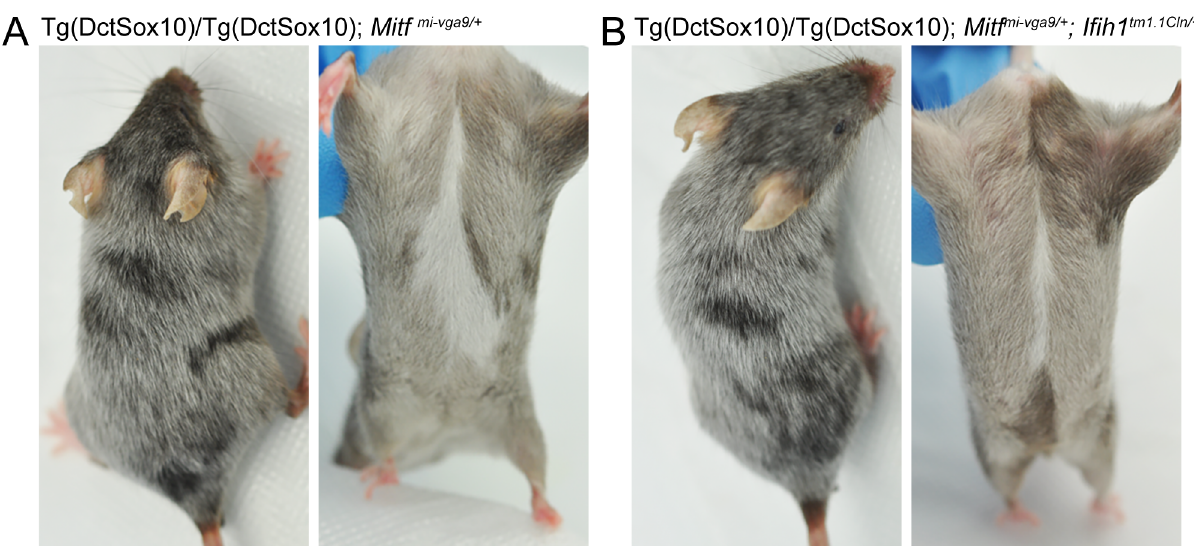
Fig 6. Ifih1 tm1 . 1Cln/+ does not affect hair graying in Tg(Dct-Sox10)/Tg(Dct-Sox10); Mitf mi-vga9/+ mice. (A, B) Images of Tg(Dct-Sox10)/Tg(Dct- Sox10); Mitf mi-vga9/+ and Tg(Dct-Sox10)/Tg(Dct-Sox10); Mitf mi-vga9/+ ; Ifih tm1 . 1Cln/+ littermates imaged at postnatal day 95. (A) Tg(Dct-Sox10)/Tg(Dct- Sox10); Mitf mi-vga9/+ animals exhibit a white belly spot at birth and premature hair graying as they age. (B) Tg(Dct-Sox10)/Tg(Dct-Sox10); Mitf mi-vga9/+ ; Ifih tm1 . 1Cln/+ animals also exhibit hair graying and a belly spot that is slightly reduced in size. Images shown here are representative of five biological replicates for each genotype, with additional images provided in S3 Fig . Ifih1 ; interferon induced with helicase C domain 1; Mitf , melanogenesis associated transcription